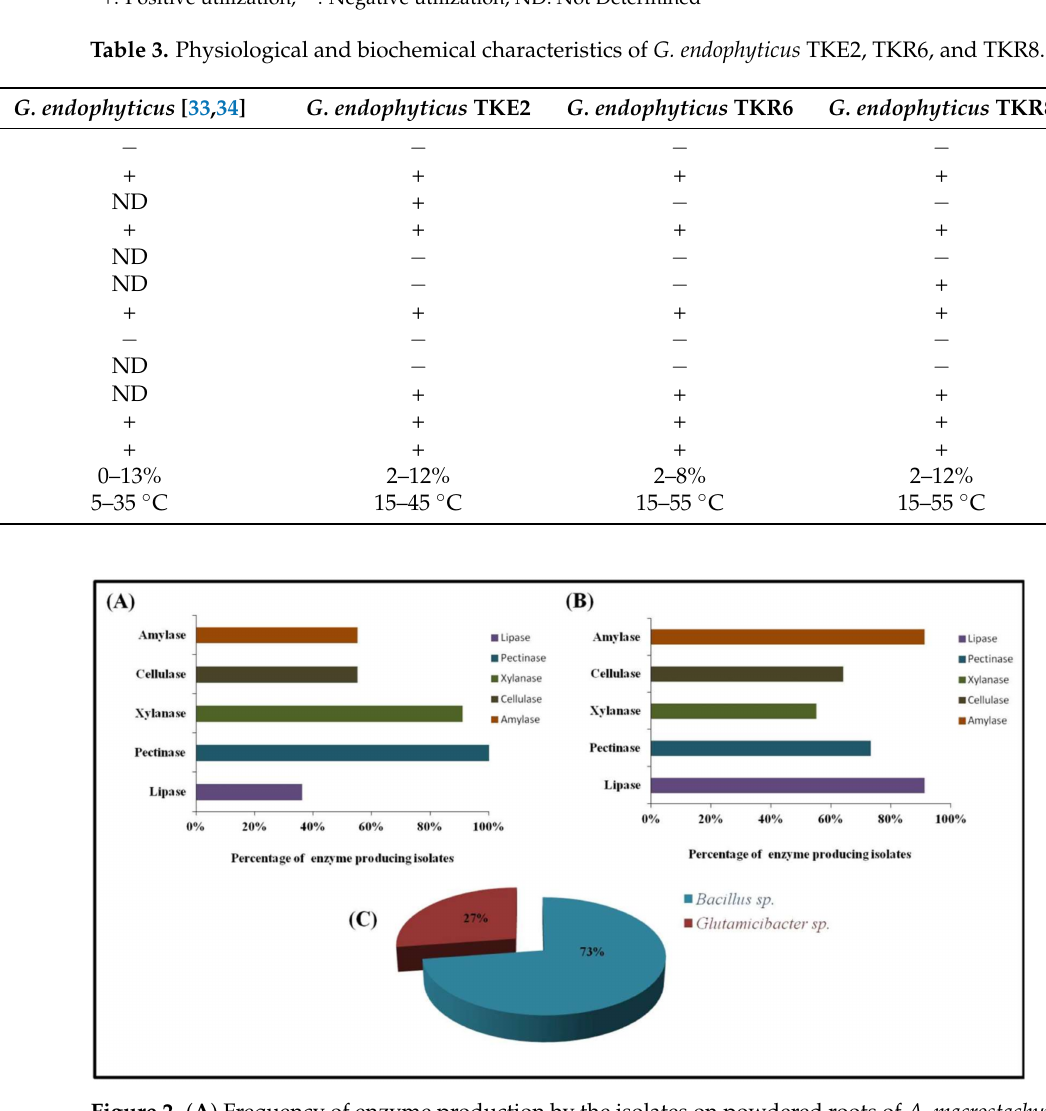
Figure 2. ( A ) Frequency of enzyme production by the isolates on powdered roots of A. macrostachyum as substrate. ( B ) Frequency of enzyme production by the isolates on respective commercial substrates. ( C ) Distribution of bacterial genera among the identified